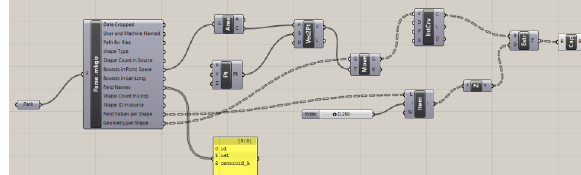
Figure 14: Shapefile import through the “Parsee Meerkat file” component